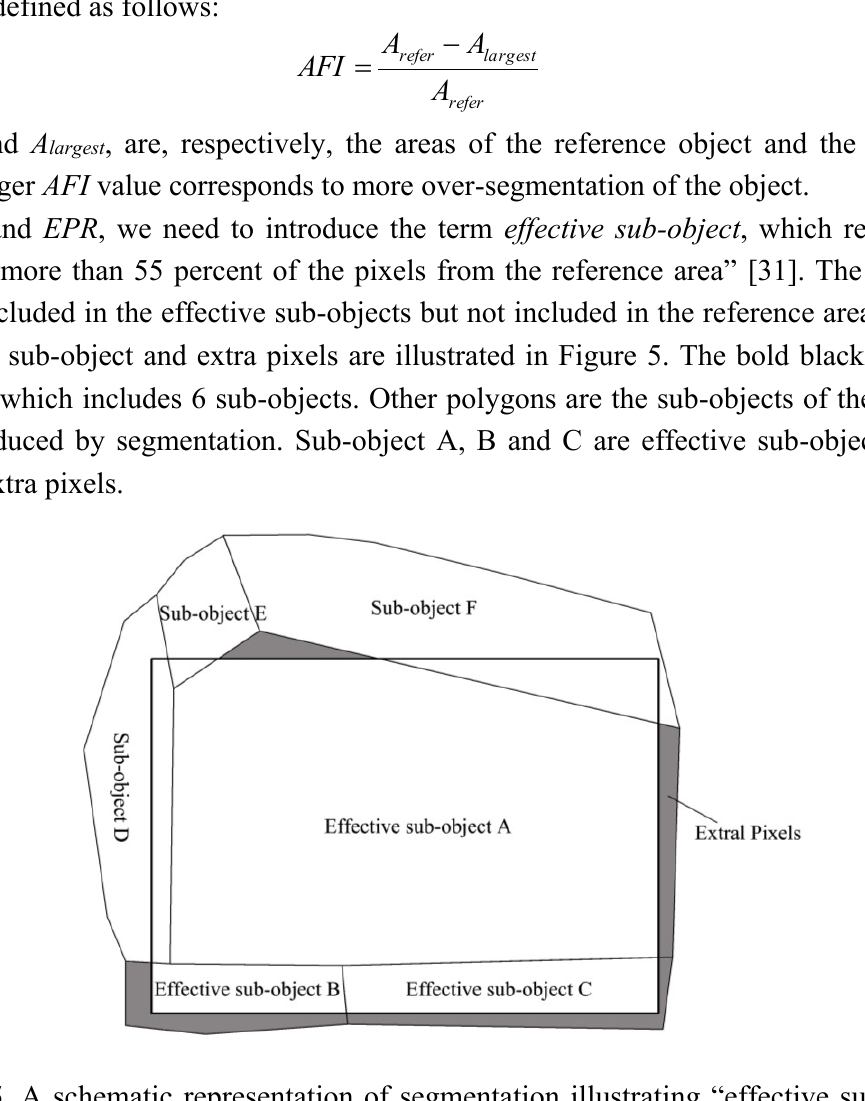
Figure 5. A schematic representation of segmentation illustrating “effective sub-objects” and “extra pixels”. The bold black rectangle is the reference area which includes 6 sub-objects. Sub-object A, B and C are effective sub-objects and the gray areas are the extra